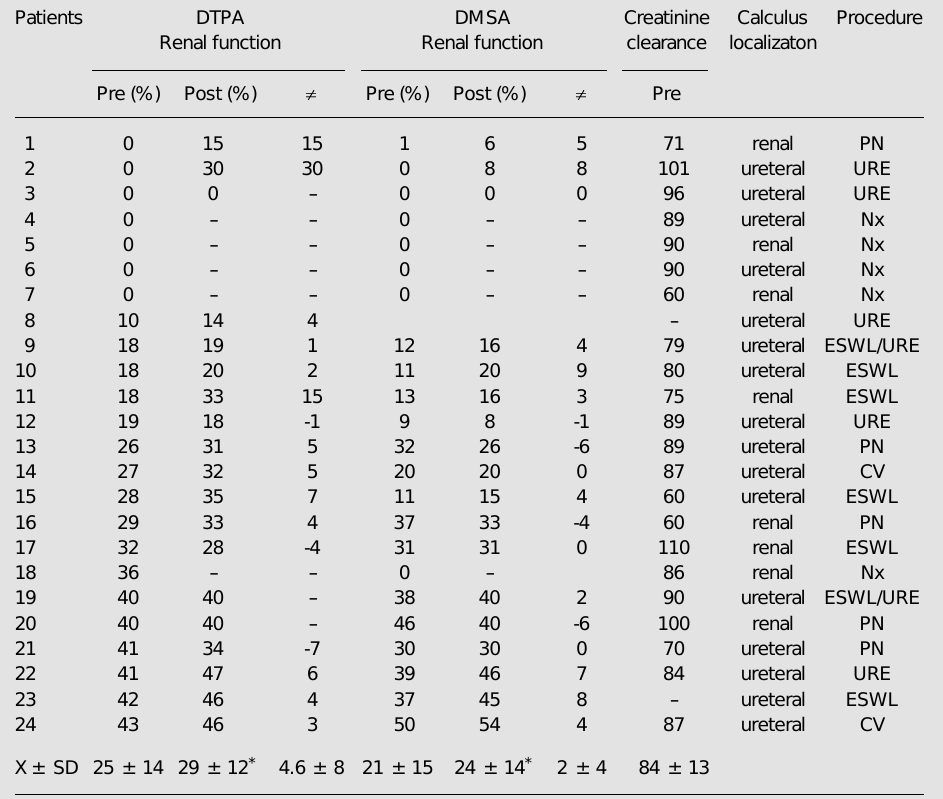
Table 3. DTPA and DMSA evaluation: percent renal function (%) and renal function difference ( „ ) before (Pre) and after (Post) relief of obstruction and renal function (creatinine clearance), calculus localization and procedure for relief of